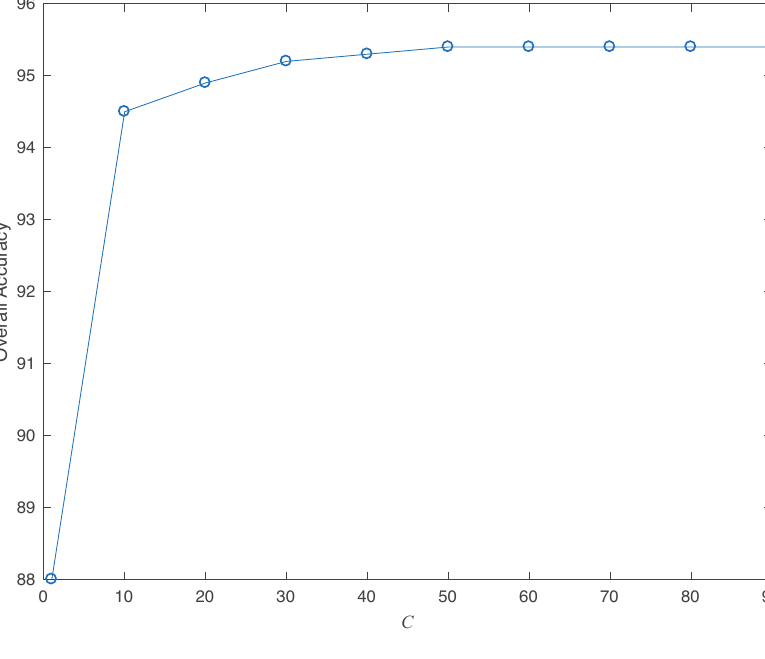
Figure 5. Box constraint value with respect to overall